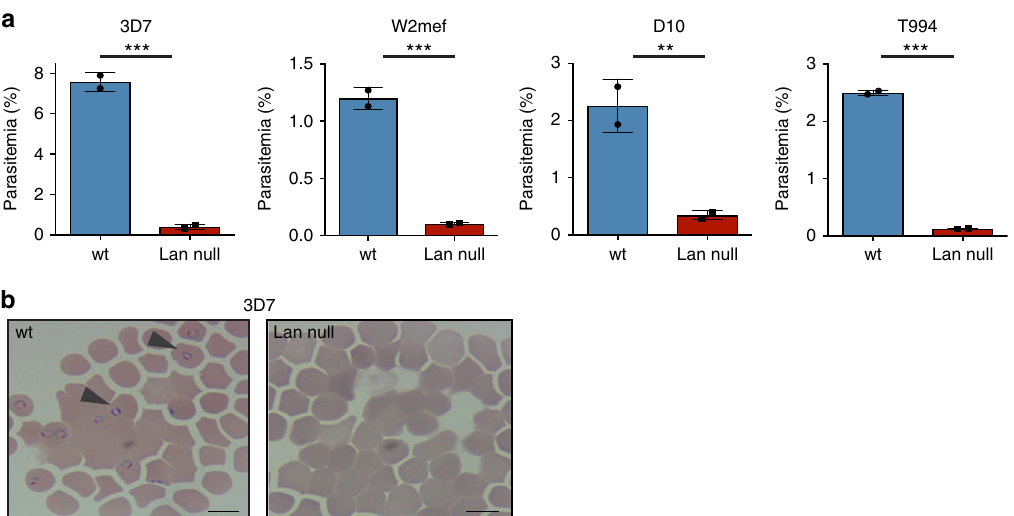
Fig. 1 Plasmodium falciparum invasion is impaired in erythrocytes that lack the Lan antigen. Comparison of P. falciparum invasion into erythrocytes from a Lan null or normal donor. a Four different laboratory-adapted strains of P. falciparum (3D7, W2mef, D10, and T994) were incubated at the late schizont stage with wt or Lan null erythrocytes, and reinvasion was measured by SYBR green I staining and fl ow cytometry. Values are expressed as mean parasitemia ±SD, n = 2. *** p < 0.005, ** p < 0.03, two-tailed t -test. b Images of P. falciparum invasion assays in control or Lan null erythrocytes. Arrows indicate ring- stage parasites. ×100 magni fi cation. Scale bars are 10 µ